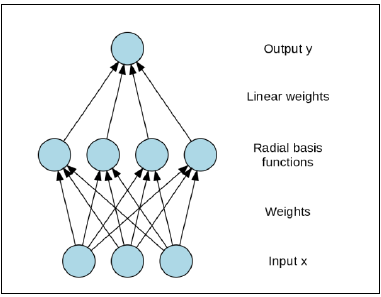
Figure 4. Architecture of a radial basis function